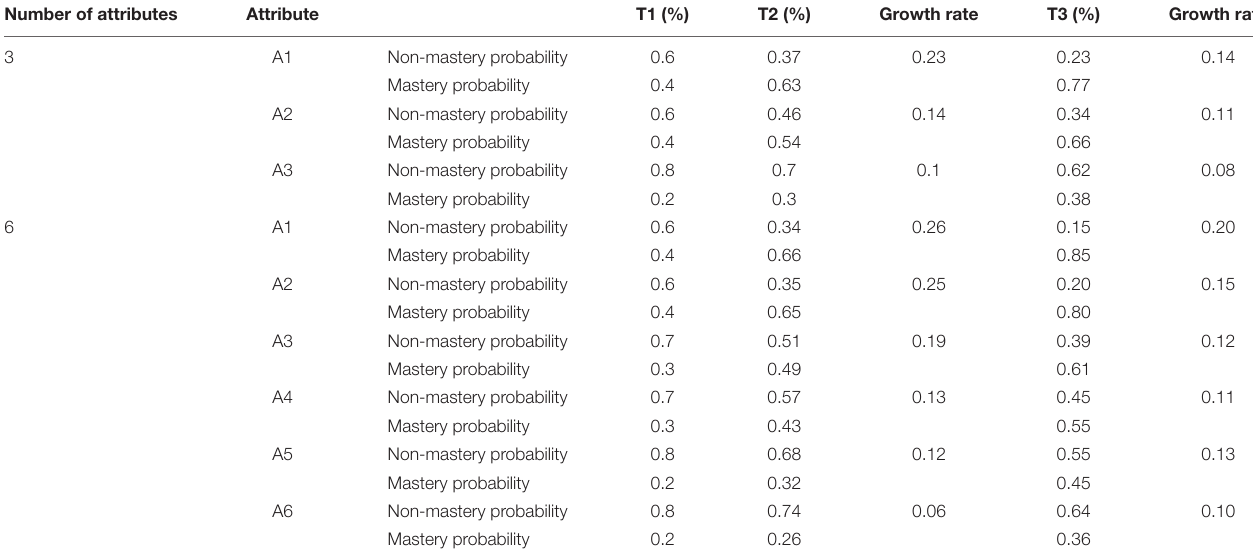
TABLE 3 | Attribute mastery probability and growth rate. Number of attributes